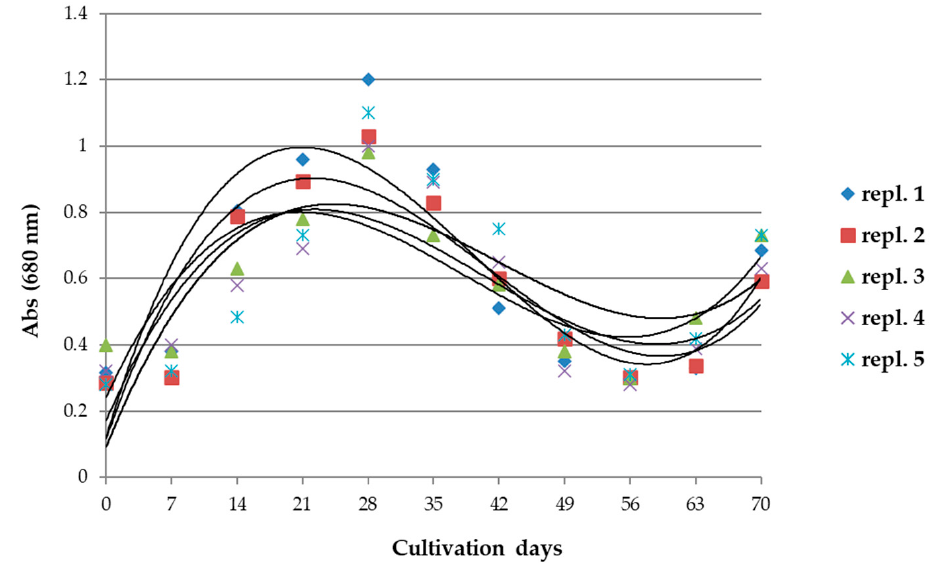
Figure 1. Absorbance values of A. maxima samples, taken every 7 days in 2 reference cultivations for a period of 70 days. Growth curves (polynomial of 3rd degree) were calculated for each group of samples. n = 5. See Supplementary Table S1A for details.